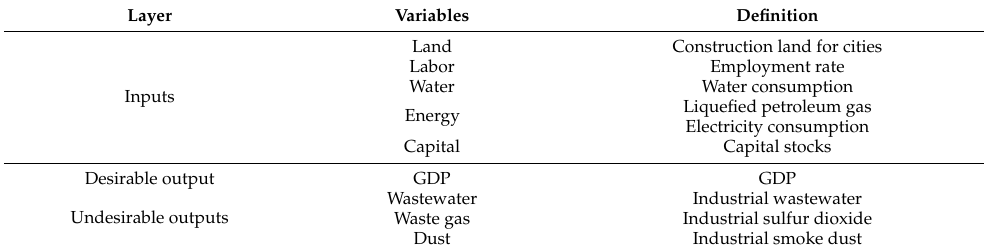
Table 2. Indicator system for the SBM model.